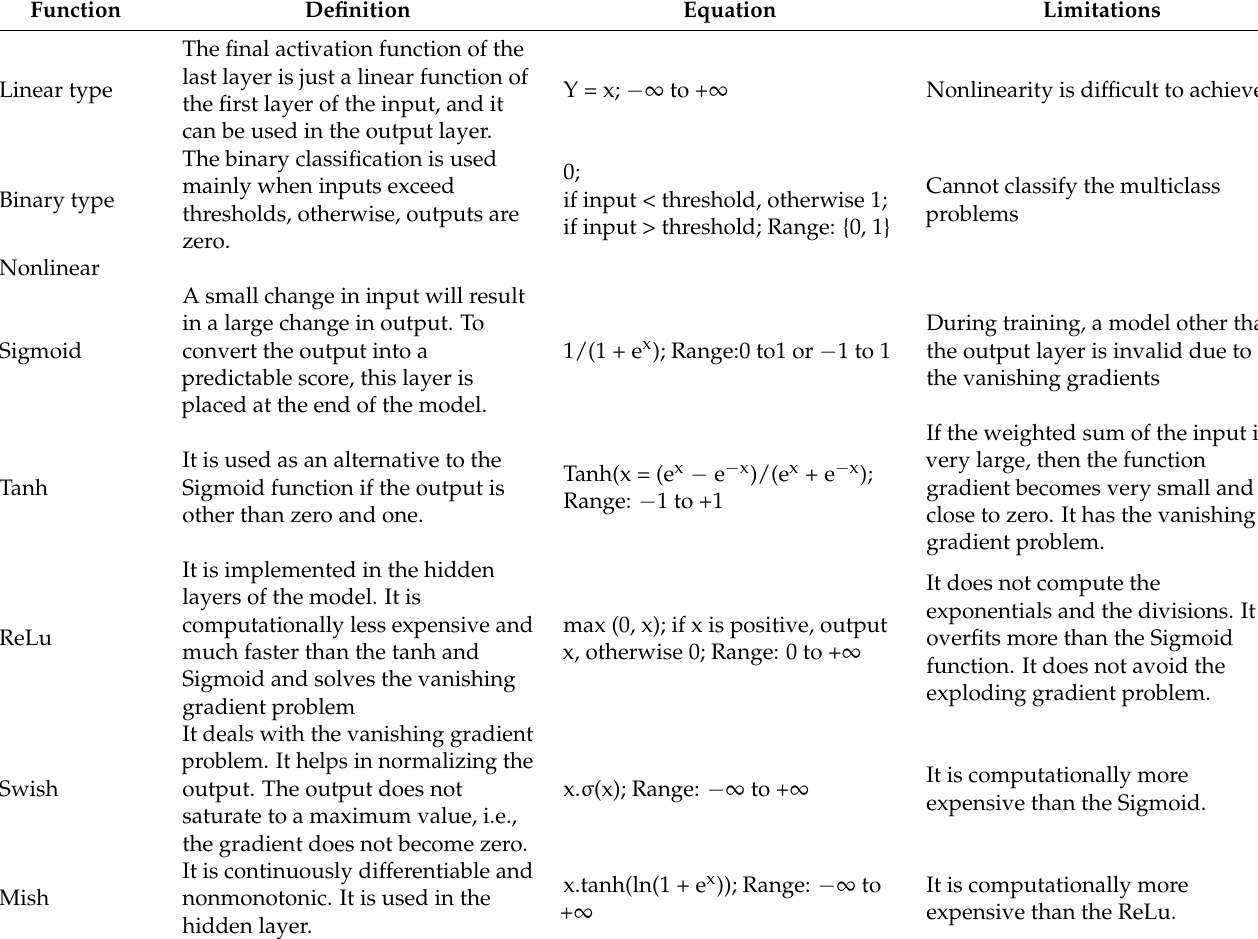
Table 1. Different activation functions and